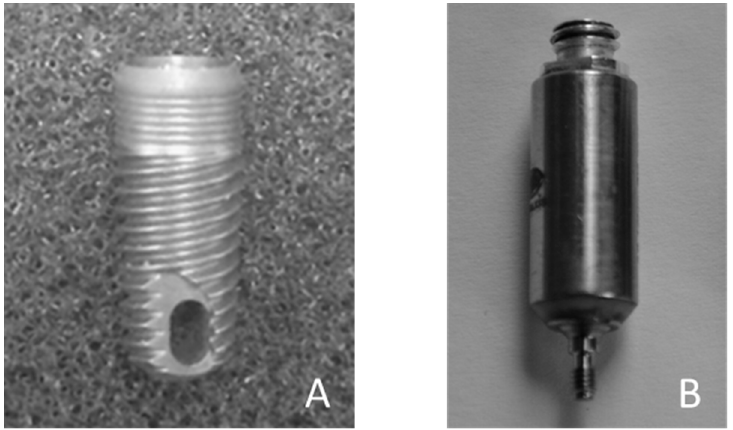
Figure 1. ( A ) Dental implant (Zimmer Biomet, TSVT4B10); ( B ) Planar ultrasonic contact